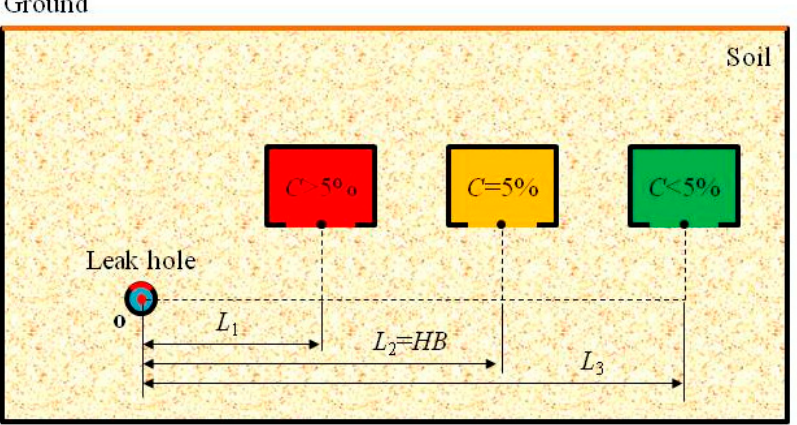
Figure 12. Schematic diagram of hazardous boundary of buried gas pipeline and underground Figure 12. S chematic diagram of hazardous boundary of buried gas pipeline and underground con- confined fined space.